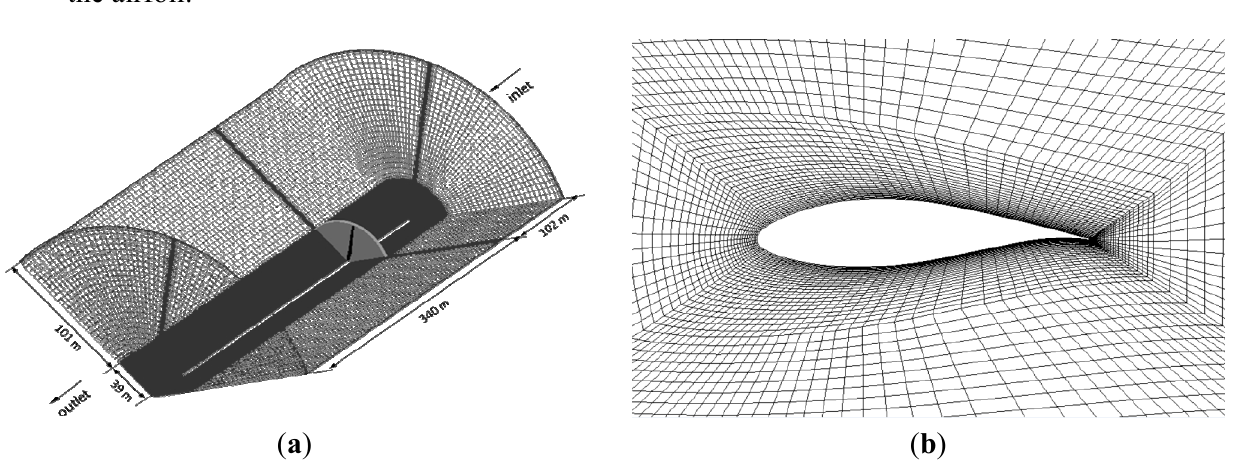
Figure 2. ( a ) Structured hexahedral grid of total domain. ( b ) Quad meshes around the